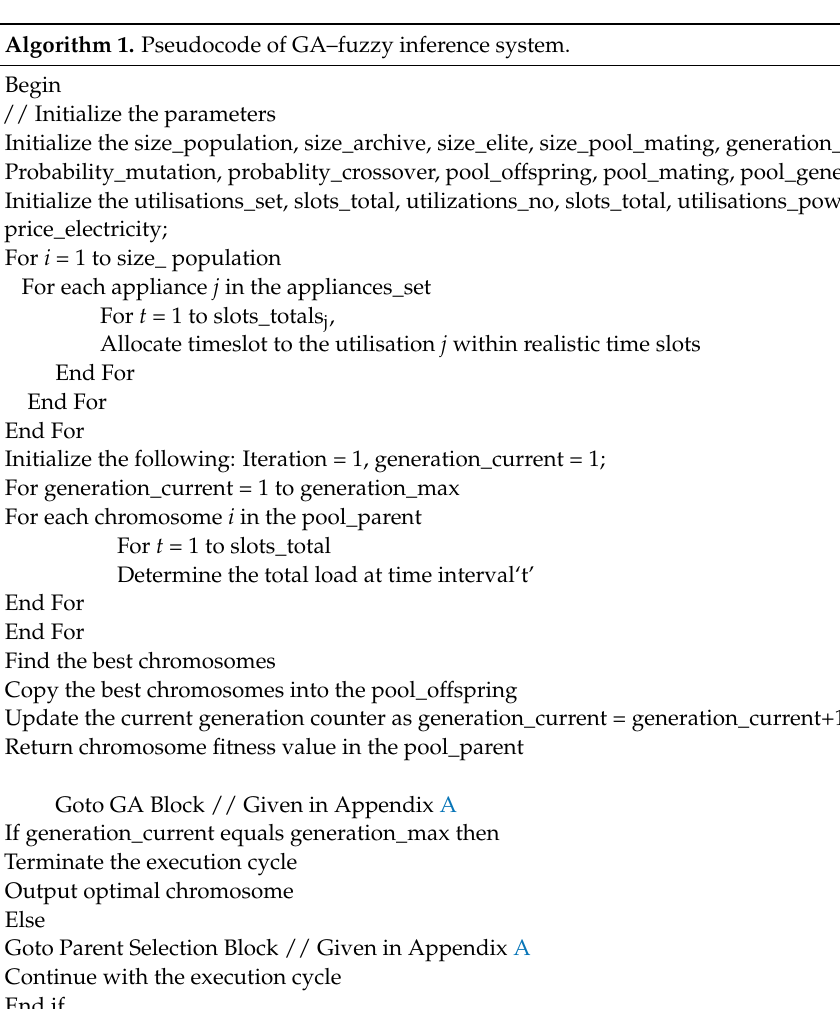
Algorithm 1. Pseudocode of GA–fuzzy inference